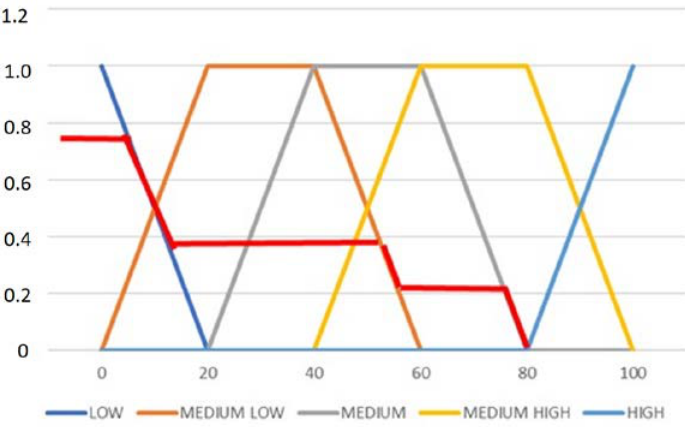
Figure 9. Aggregation of rules for assembly technology